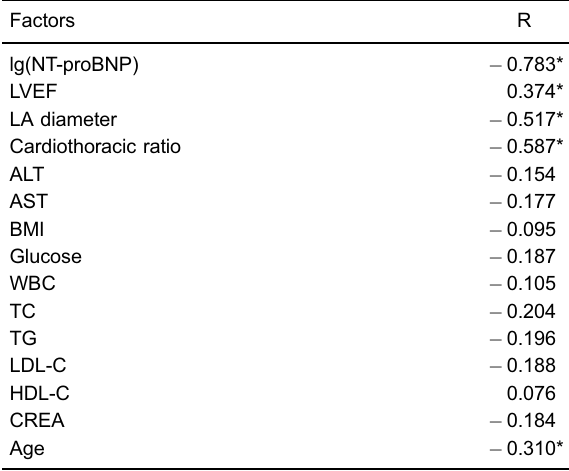
Table 5. Pearson ’ s correlation analysis between serum micro- RNA-126 levels and clinical and laboratory characteristics in HF- AF